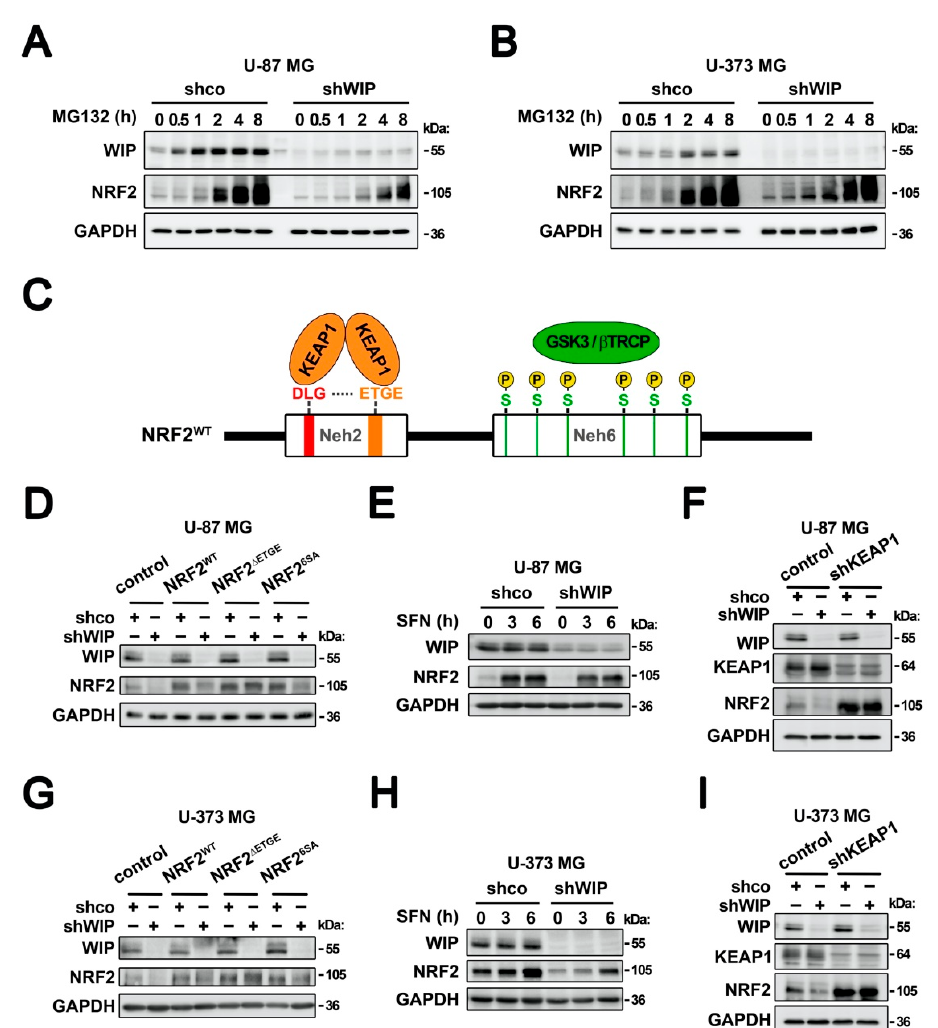
Figure 2. The regulation of NRF2 by WIP is KEAP1-dependent. ( A , B ) Time-dependent accumulation of NRF2 in control and WIP-silenced U-87 MG ( A ) and U-373 cells ( B ) and cells treated with 10 µM of MG132. ( C ) Scheme of the two domains of NRF2, Neh2 and Nhe6, which are targeted for proteasome degradation. A KEAP1 homodimer binds the N-terminal region of NRF2 (Neh2 domain) through interaction with a low affinity (DLG) and high affinity (ETGE) amino acid motifs. Thus, the mutated version of NRF2 that lacks the ETGE motif (NRF2 Δ ETGE ) is insensitive to KEAP1-mediated degradation [20]. On the other hand, several phosphorylation events, in which Glycogen synthase kinase 3 (GSK-3) is an essential kinase, generate a degradation domain (phosphodegron) that is recognized by the E3 ligase adapter β -TrCP. Thus, the mutated version of NRF2 in which six serines involved in the generation of the phosphorylation have been changed to alanines (NRF2 6SA ) generates a NRF2 insensitive to β -TrCP-mediated degradation [29]. ( D , G ) Immunoblots of WIP, NRF2, and GAPDH as a loading control of U-87 MG (D) and U-373 MG ( G ) cells that were transduced with lentiviral vectors expressing NRF2 WT , NRF2 Δ ETGE , NRF2 6SA or with empty vector as control and then with a lentivirus expressing shco or shWIP. ( E , H ) immunoblots of WIP, NRF2, and GAPDH as a loading control of U-87 MG ( E ) and U-373 MG ( H ) glioblastoma cells that were transduced with lentiviral vectors containing shco or shWIP and then treated with 15 µM of SFN. ( F , I ) Immunoblots of WIP, KEAP1, NRF2, and GAPDH as a loading control of U-87 MG ( F ) and U-373 MG ( I ) glioblastoma cells that were transduced with lentiviral vectors containing shco or shKEAP1 or shWIP, as indicated.